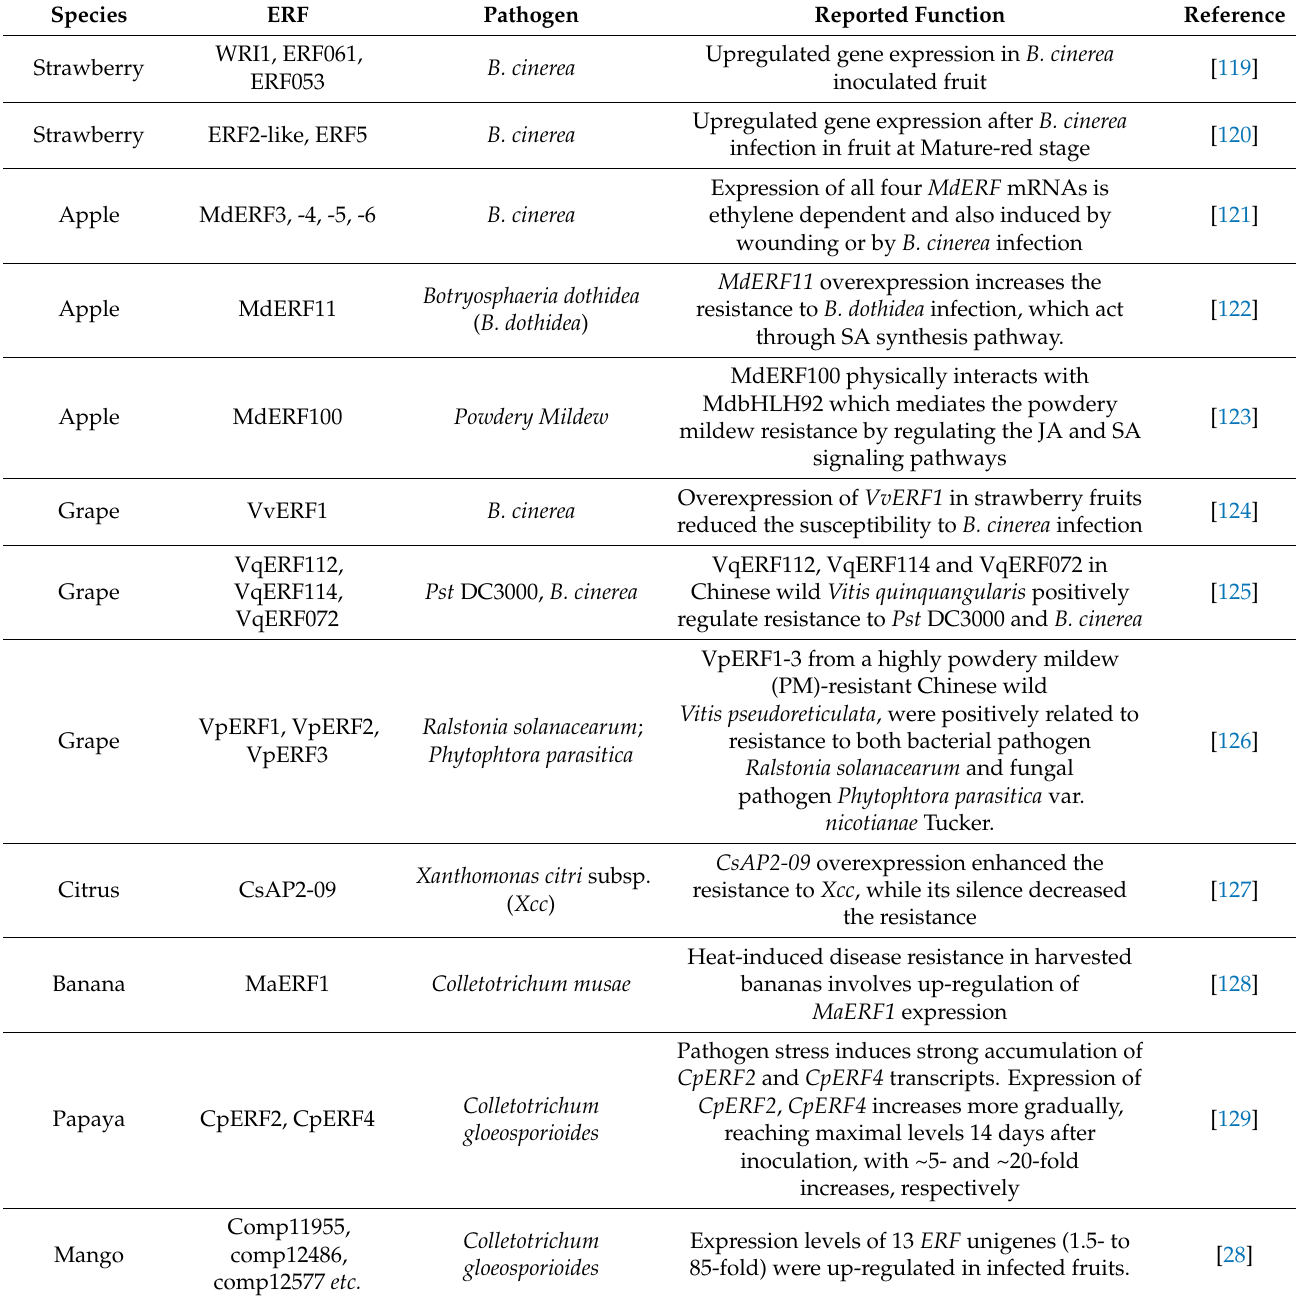
Table 2. ERFs involved in pathogenic responses of other fleshy